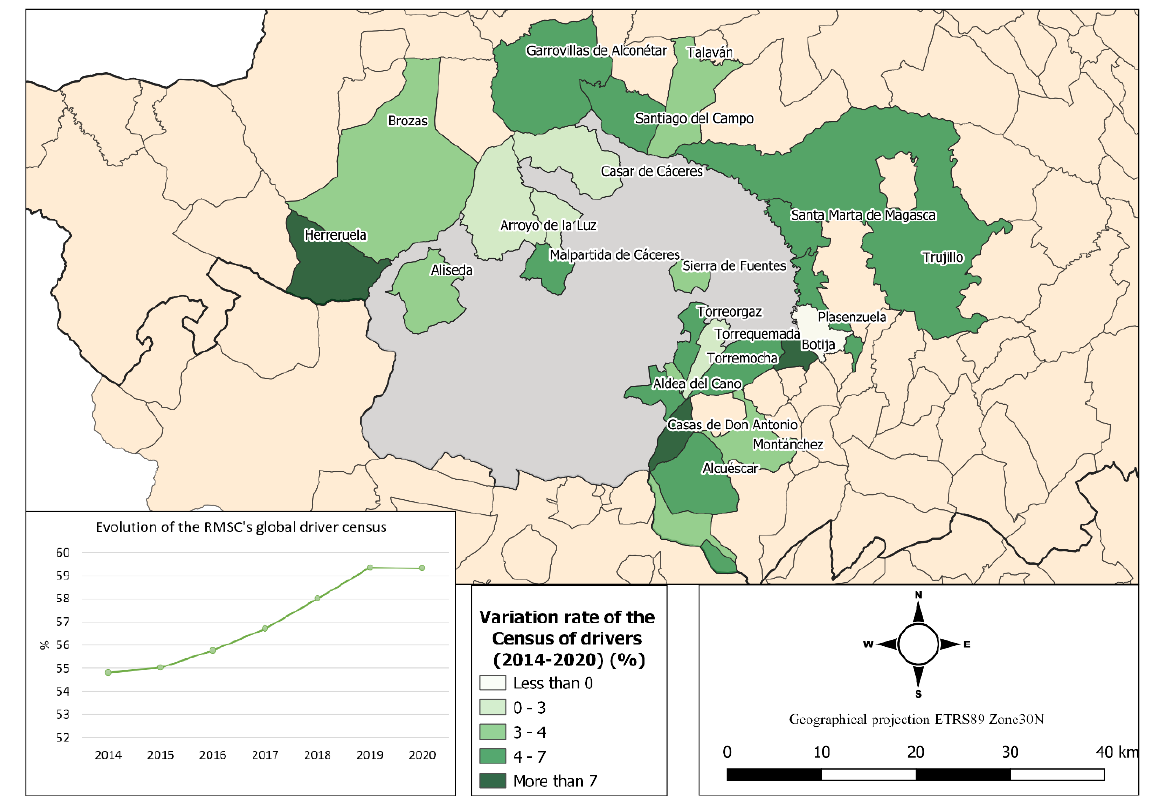
Figure 3. RMSC driver census (2014 – 2020).